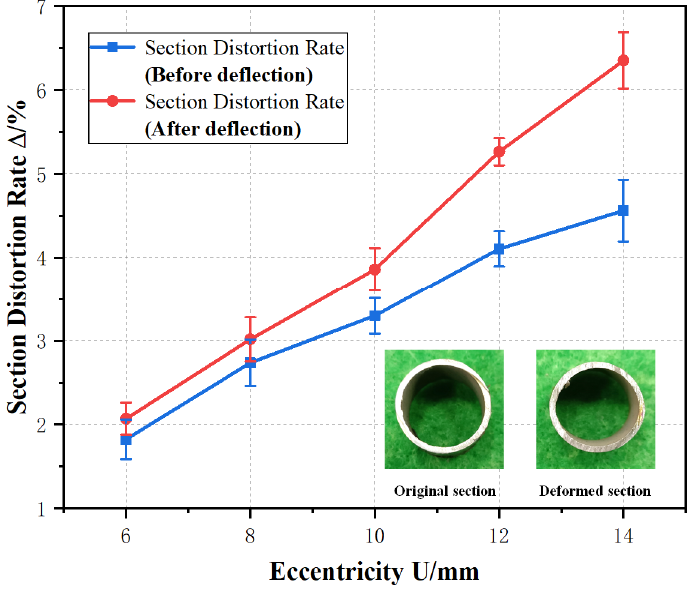
Figure 18. Section distortion comparison before and after active deflection with bell-shaped struc- ture.